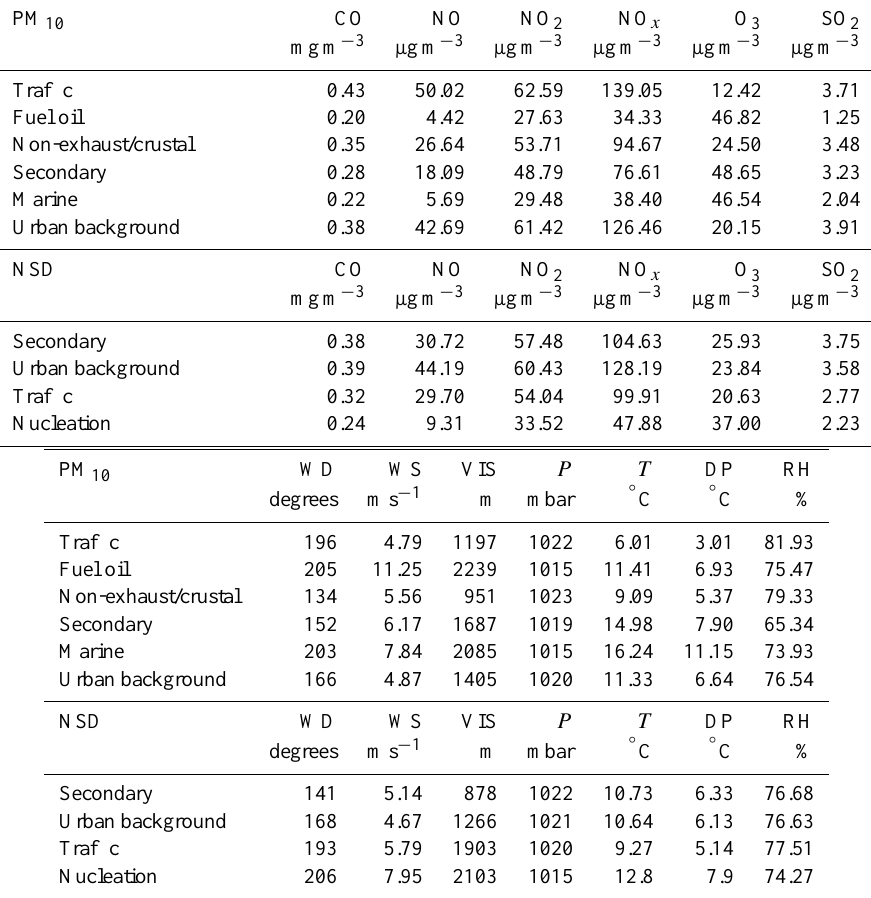
Table 2. Average concentrations of gas-phase pollutants and meteorological conditions corresponding to the periods when each factor in the PMF results for the PM 10 chemical and NSD exceeded its 90 percentile value. (WD – wind direction; WS – wind speed; VIS – visibility; P – pressure; T – temperature; DP – dew point; RH – relative